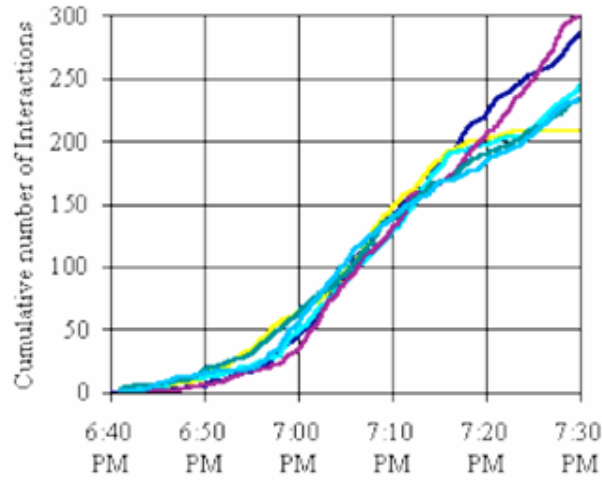
Figure 10. Cumulative number of messages during the greeting stage for each class